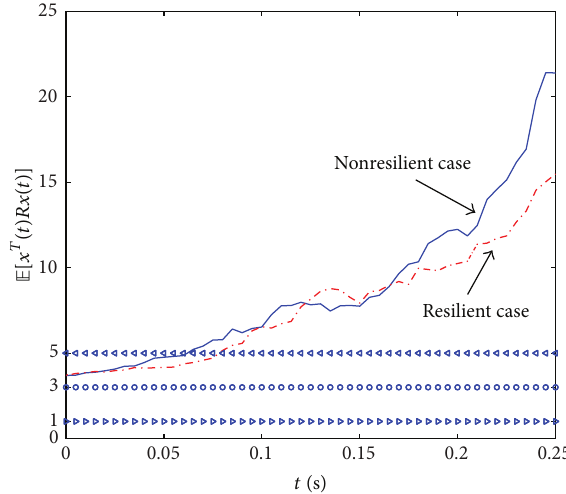
Figure 3: The response of system (1) for E [𝑥 𝑇 (𝑡)𝑅𝑥(𝑡)]